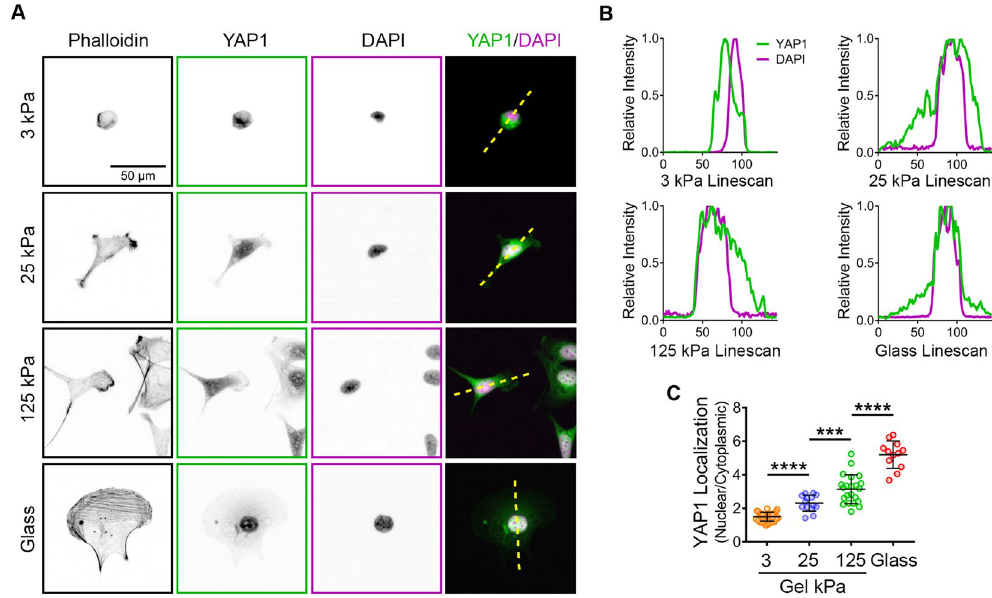
Figure 10. Substrate rigidity controls nuclear localization of YAP1 in ovarian cancer cells. ( A ) SKOV3 cells plated on FN-coated hydrogels with elastic moduli of 3 kPa, 25 kPa, and 125 kPa, or on FN-coated glass coverslips, as indicated, were allowed to adhere for 18 h before being fixed and stained with phalloidin, YAP1 antibody, and DAPI to visualize F-actin, YAP1, and nuclei, respectively. Yellow dotted lines through the cells in the overlay images (last column) were used to generate the intensity linescans shown in the next panel. ( B ) Plotted intensity of YAP1 and DAPI signals through the linear regions of interest depicted in ( A ). The y-axes represent relative fluorescence intensity of the indicated signals and the x-axes represent the position along the linear ROI. ( C ) Quantification of YAP1 localization given as a ratio of YAP1 signal in the nucleus to that in the cytoplasm for cells on the indicated substrates. The graph depicts all measure values (colored symbols) and the mean values ( ± s.d.; n = 34, 14, 22, and 16 cells for 3 kPa, 25 kPa, 125 kPa, and glass, respectively; *** p = 0.0025; **** p < 0.0001 using Mann-Whitney